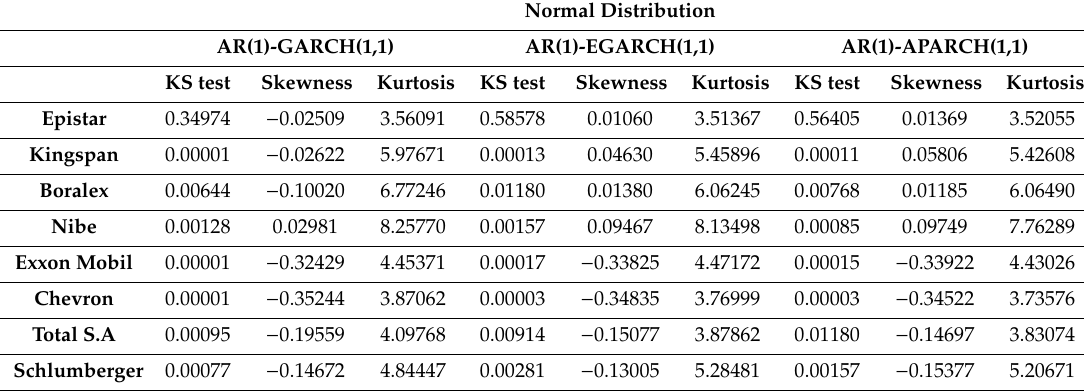
Table A5. Two-sample Kolmogorov-Smirnov tests, skewness and kurtosis estimation of